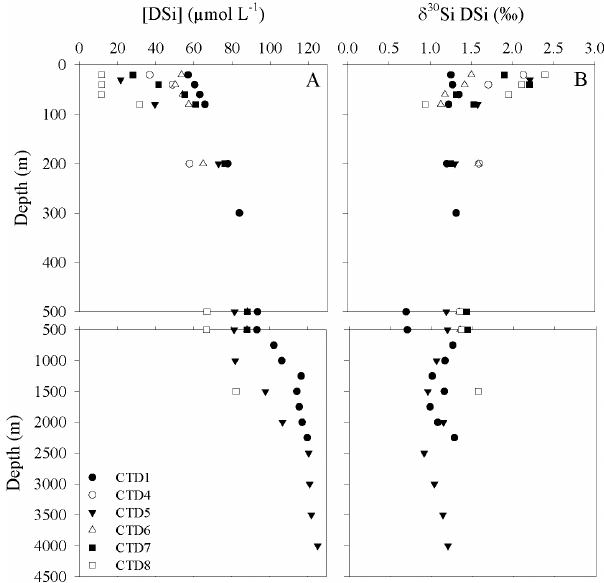
Fig. 3. Profiles of (A) DSi concentration data versus depth and (B) δ 30 Si DSi versus depth from the CTD